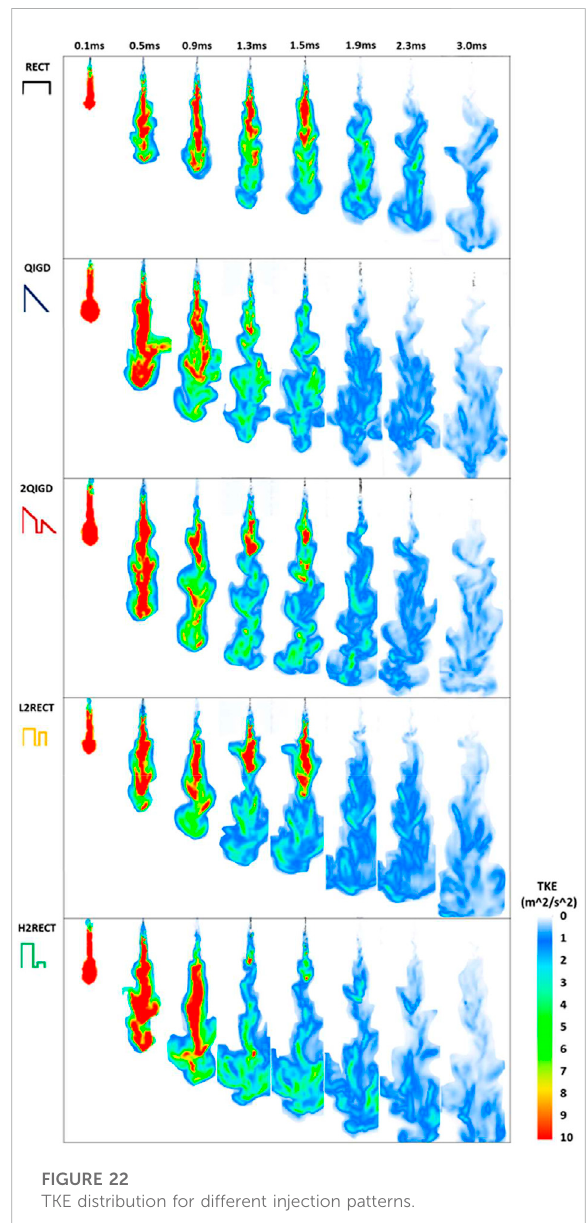
FIGURE 22 TKE distribution for different injection